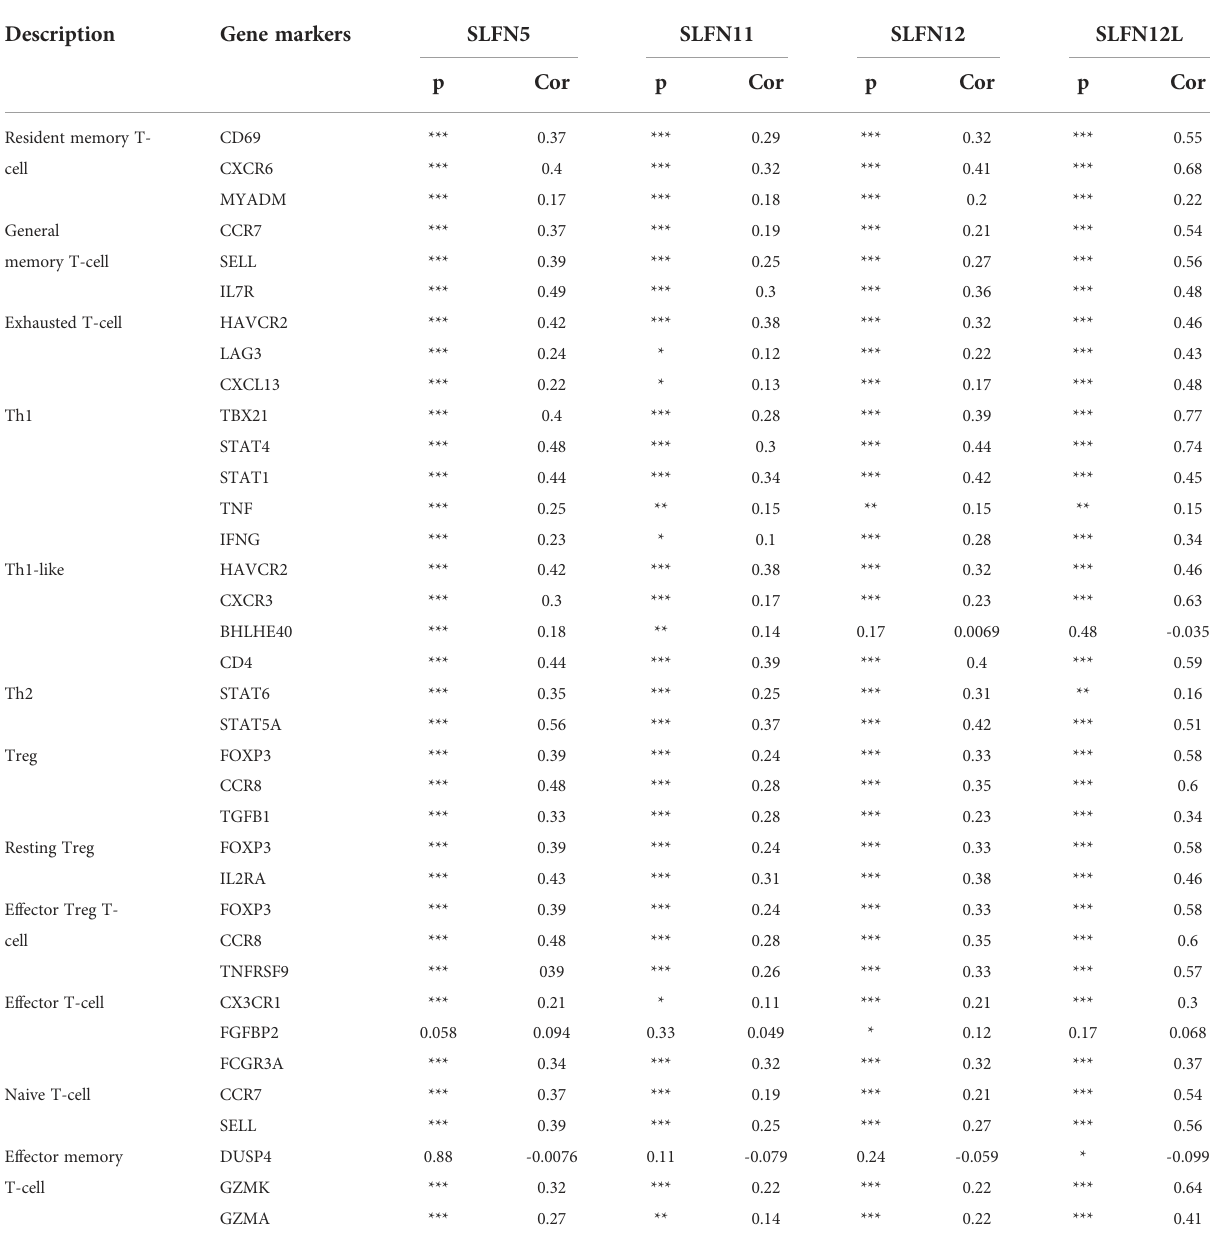
TABLE 5 Correlation between SLFN and gene markers of T cells in GEPIA.